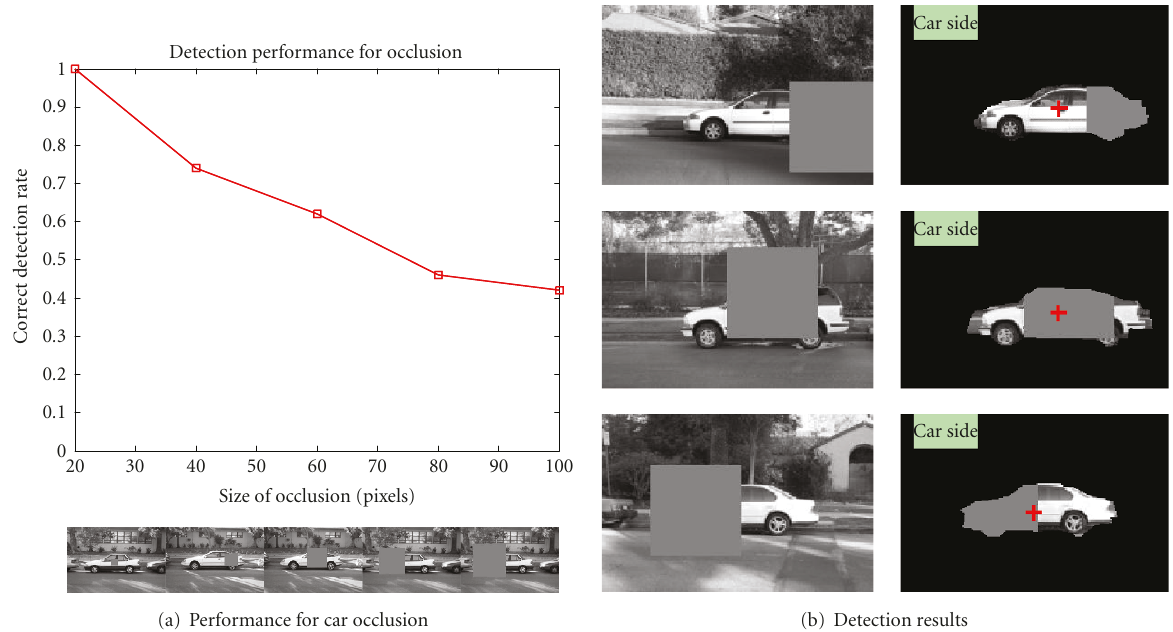
Figure 28: Detection performance under occlusion and several detection